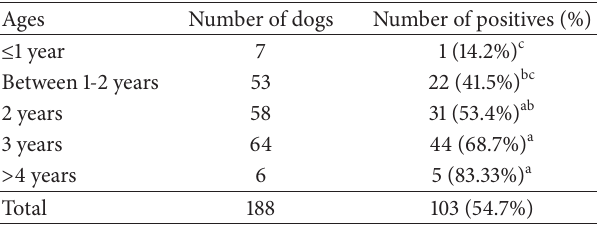
Table 2: Age distribution of dogs detected